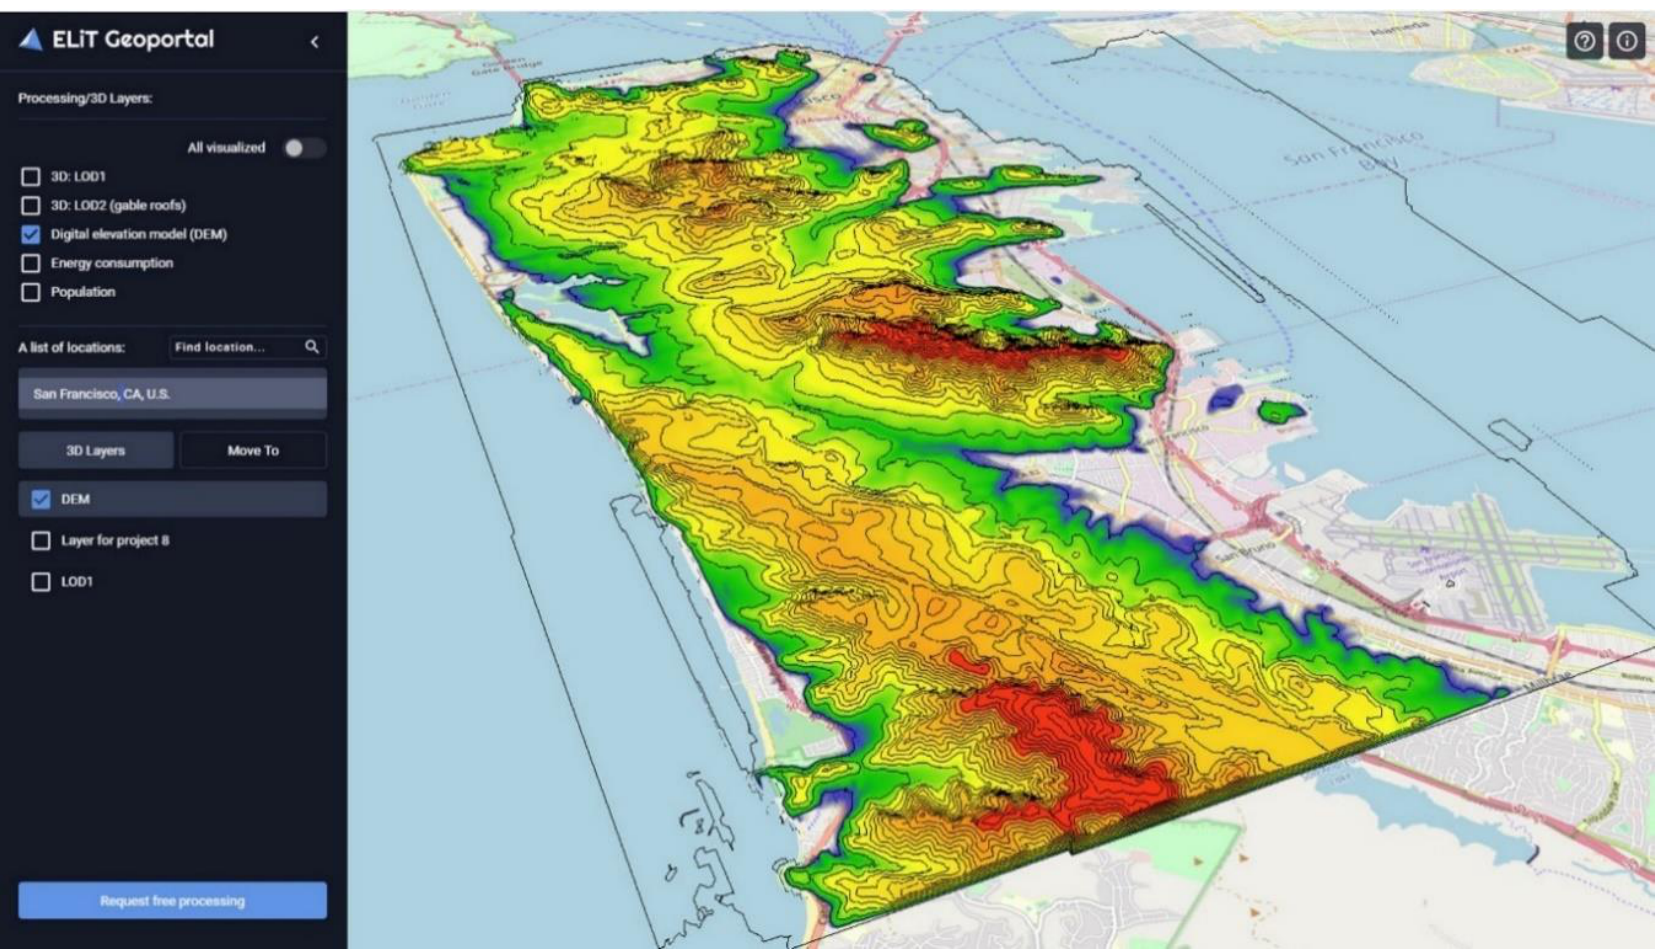
Figure 8. An urban area DEM of San Francisco computed on the base of the Ground branch of the two-branched algorithm (Figure 1). It is visualized on the EGP by Cesium Terrain Provider.